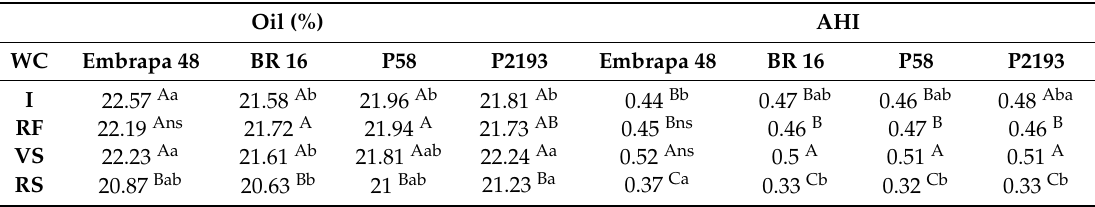
Table 5. Decomposition of the interaction water condition (WC) × genotype for oil content (%) in grains on a dry basis and apparent harvest index (AHI) in soybean genotypes grown for three crop seasons in Londrina, PR,